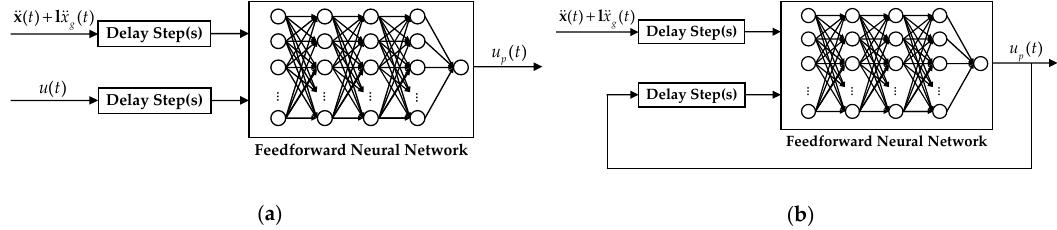
Figure9. Architecturesoftheexogenousinputs(ARX)neuralnetwork: ( a )series-parallel, and( b )parallel. Appl. Sci. 2020 , 10 , x FOR PEER REVIEW Figure 9. Architectures of the exogenous inputs (ARX) neural network: ( a ) series-parallel, and ( b ) parallel.